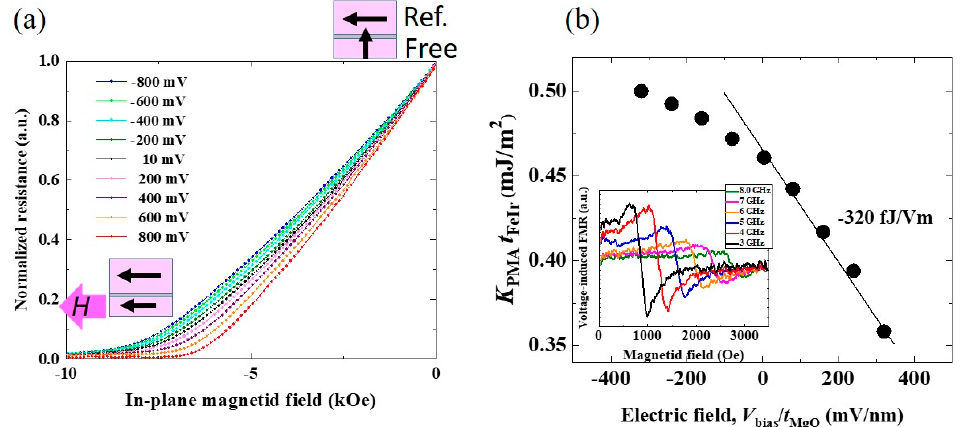
Figure 14. ( a ) Bias voltage dependence of normalized TMR curves measured under in-plane magnetic fields for an orthogonally-magnetized MTJ consisting of Cr/Ir-doped Fe(0.82 nm)/MgO/Fe(10 nm). ( b ) Applied electric-field dependence of K PMA t FeIr . The inset shows an example of voltage-induced FMR excitation measured by a homodyne detection technique, which proves the high speed responsiveness of the observed VCMA effect. Reproduced from [35]. CC BY 4.0.